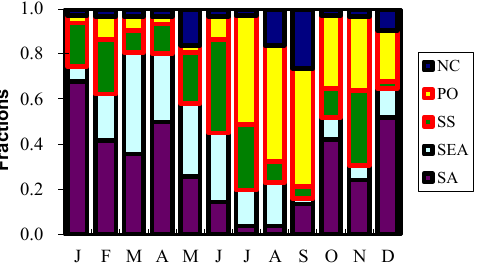
Figure 2. Monthly distributions of the fractions for various air clus- ters at Mount Hehuan during the sampling